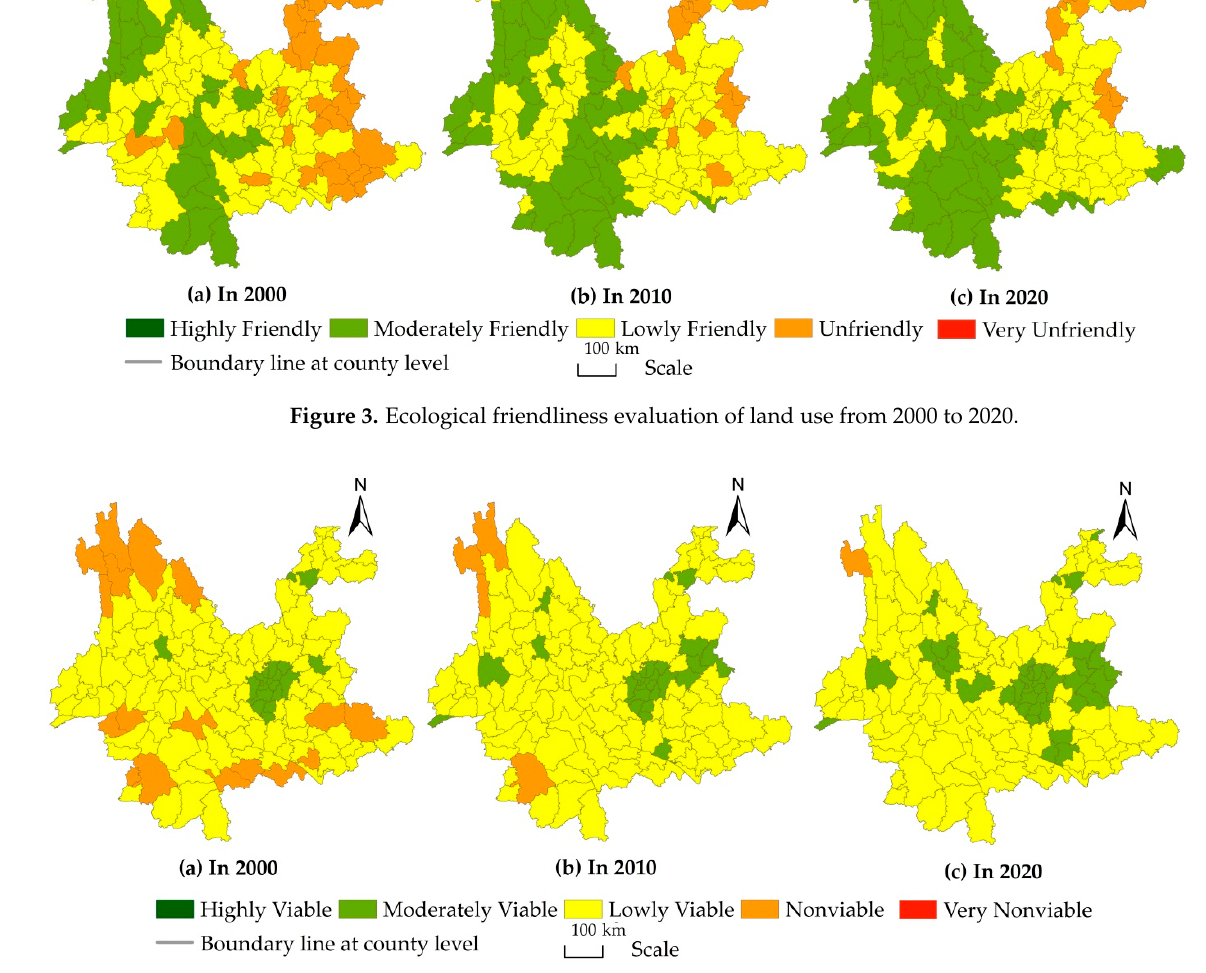
Figure 5. Social acceptability evaluation of land use from 2000 to 2020. Figure 6. Overall sustainability evaluation of land use from 2000 to 2020.